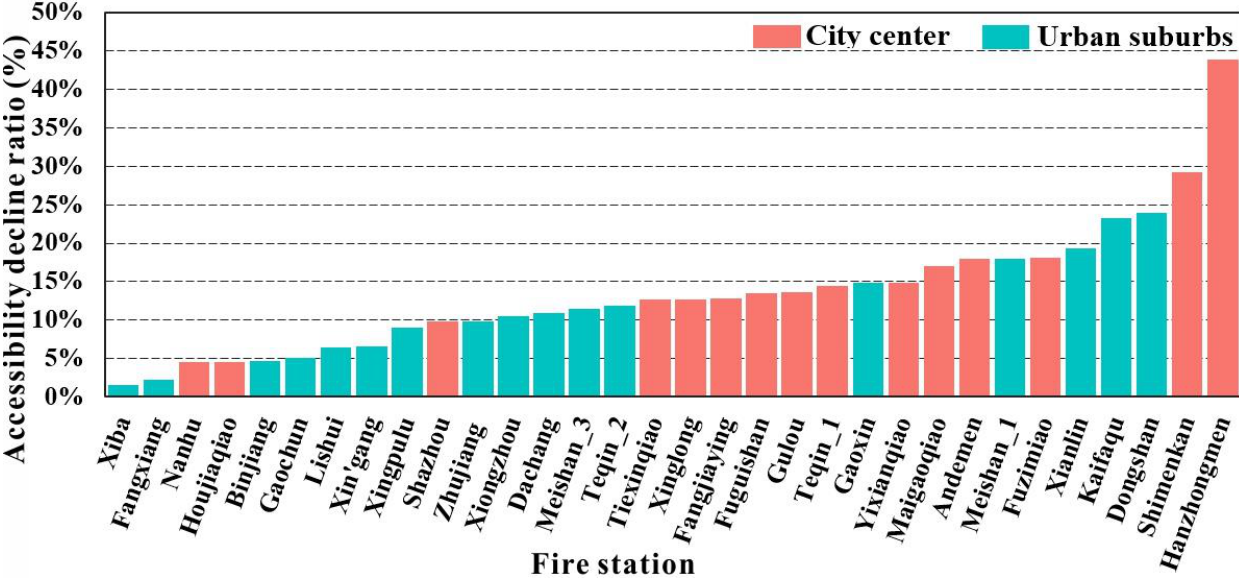
Figure 7. Accessibility decline ratio of fire stations during rush hours.